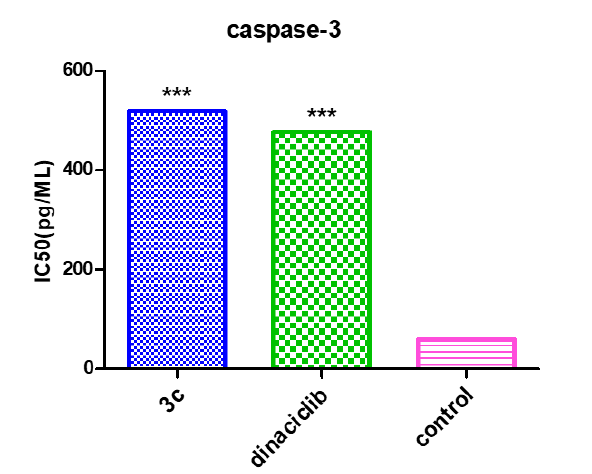
Figure 11. Caspase-3 levels of 3c and Dinaciclib on the SK-MEL-5 line relative to the control. Results indicating at *** means less significant.